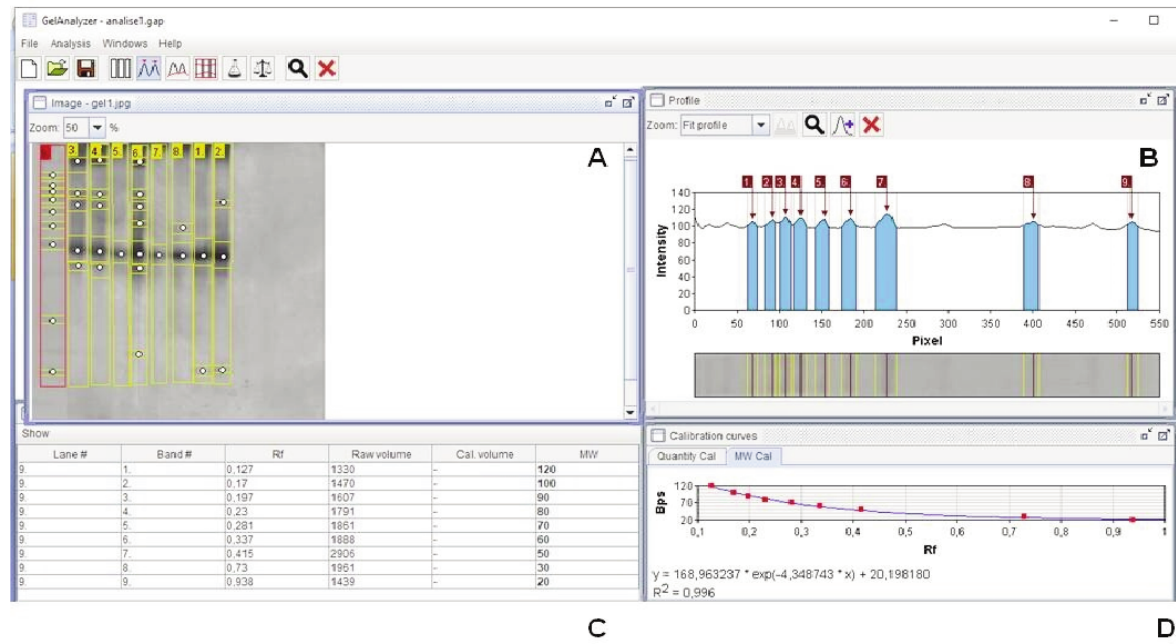
Fig. 4 ­ The main panels of Gel Analyser software showing the image of the entire electrophoresis gel (panel A); the bands from the selected lane from panel A are transformed in peaks (panel B) and their area are computed in panel C, as raw volume (conventio­ nal units). Based on the molecular weights of the markers (in panel D), the correspondence between the molecular mass and the migration (as Rf) of the protein is